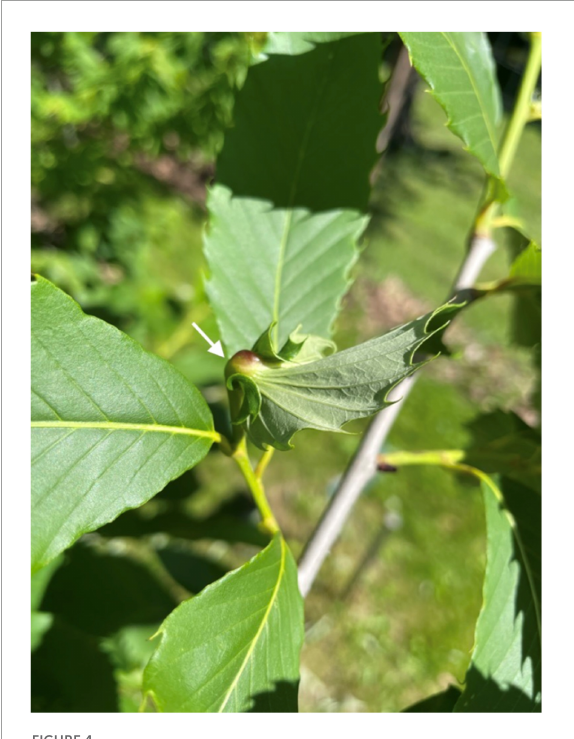
FIGURE4 Castanea spp. presenting a gall on the leaf (arrow) after Dryocosmus kuriphilus